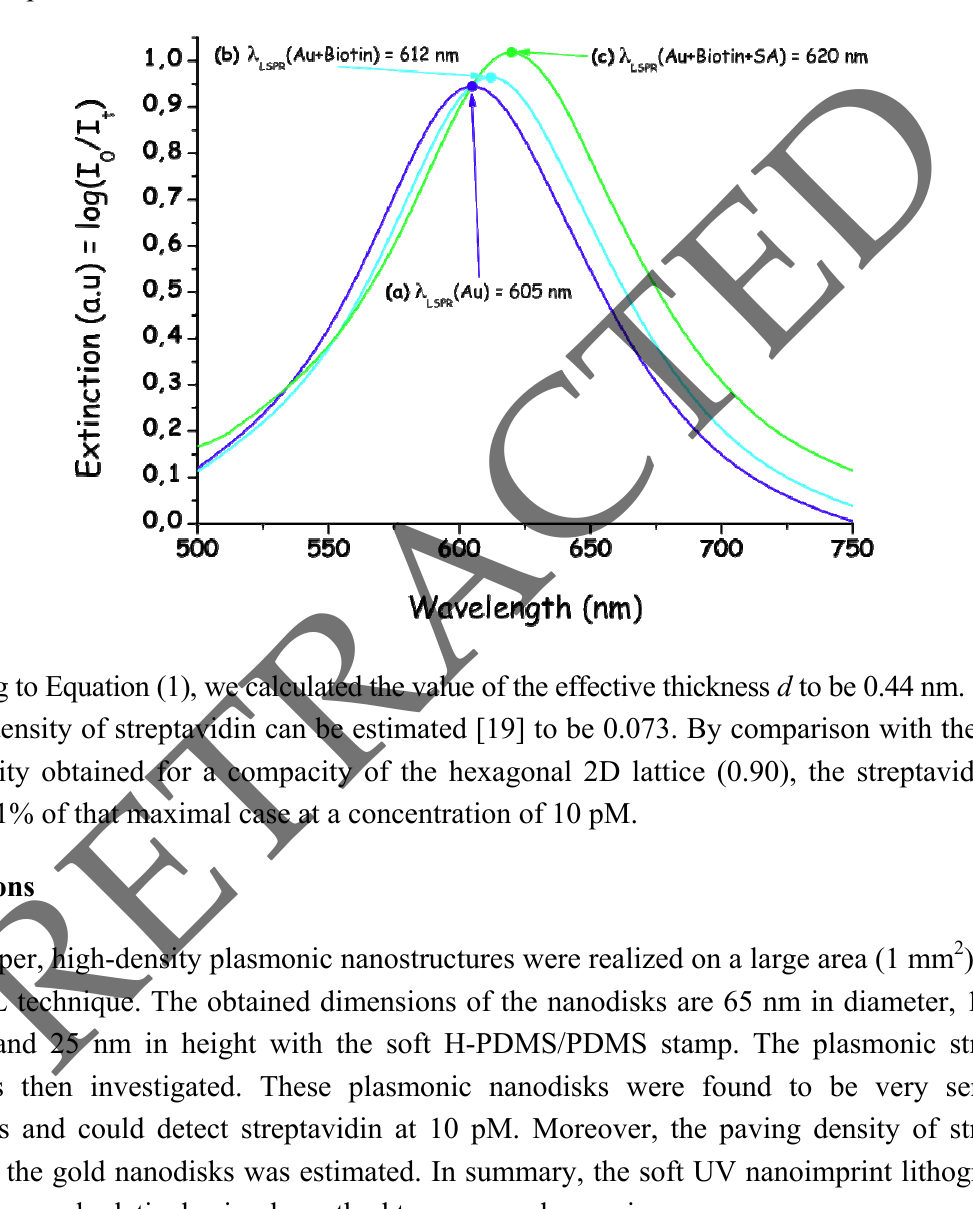
Figure 4. Smoothed extinction spectra of gold nanodisks at each functionalization step: ( a ) Au without molecular adsorption, ( b ) Au after adsorption of biotin and ( c ) Au + biotin after streptavidin